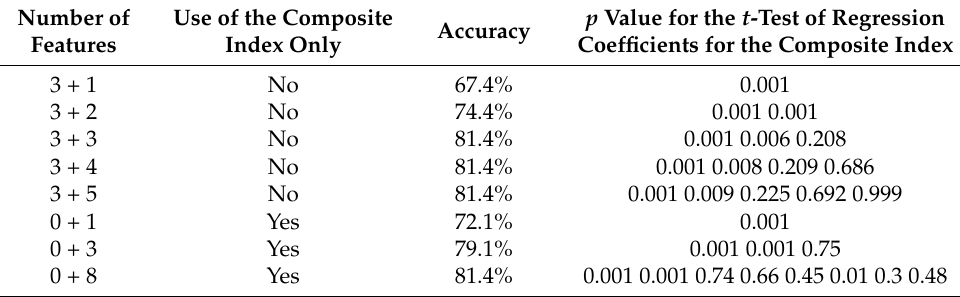
Table 2. Accuracy changes as the number of features change.